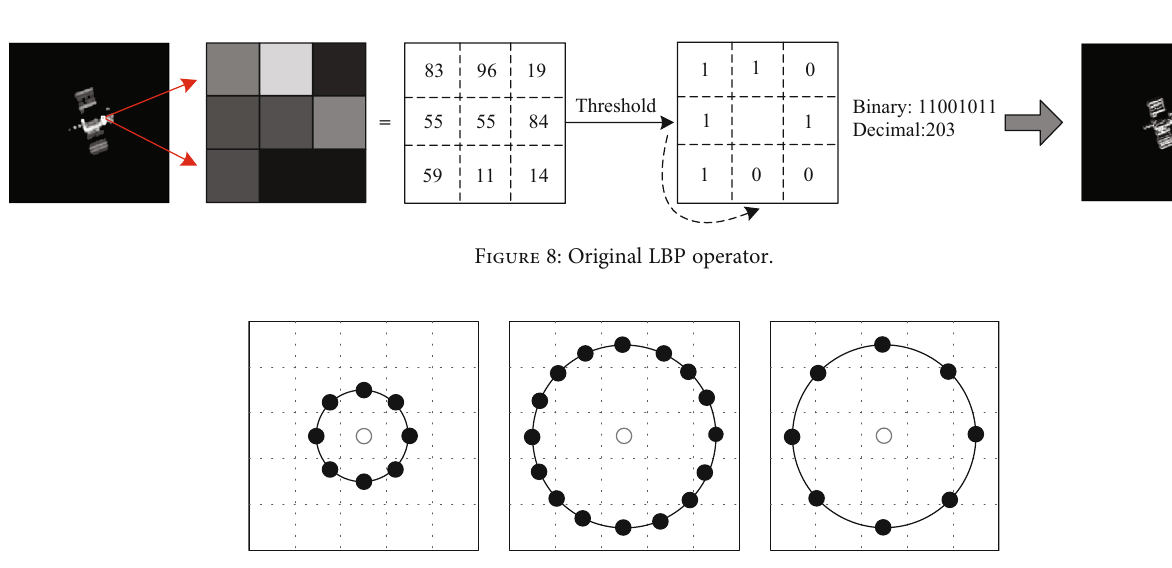
Figure 9: Circular neighborhood system of ð 1, 8 Þ , ð 2, 16 Þ , and ð 2, 8 Þ